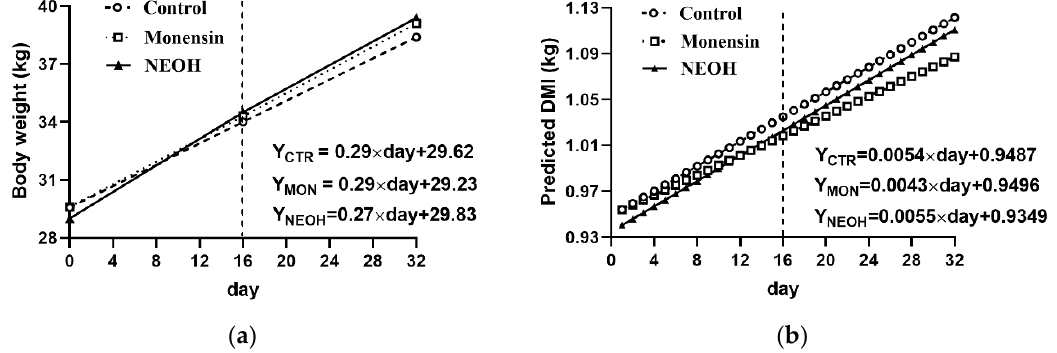
Figure 1. Supplementation effects of monensin (MON) and nitroethanol (NEOH) to lamb diet in feeding period 1 (day 0-16) and their withdrawn effects in subsequent period 2 (day 17 – 32) on live body weight ( a ) and dry matter intake (DMI, b ).